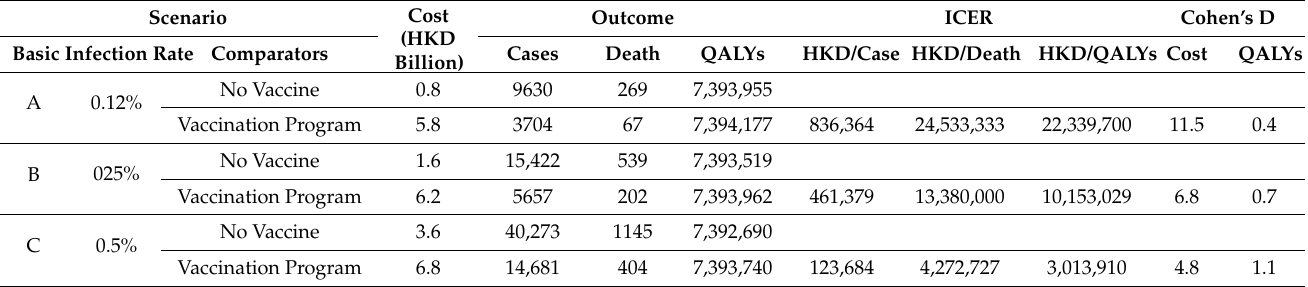
Table 3. Incremental cost-effectiveness ratio of the COVID-19 vaccination program adjusted for different levels of the basic infection rate in Hong Kong.